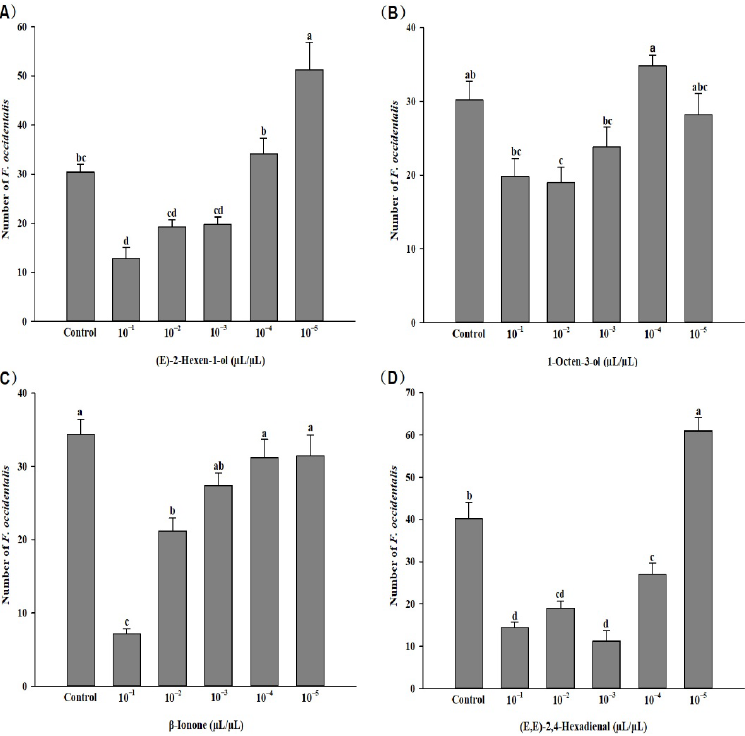
Figure 3. Response of female F. occidentalis adults to volatile compounds at different concentrations. Letters on bars indicate significant differences (Tukey’s test, p < 0.05).